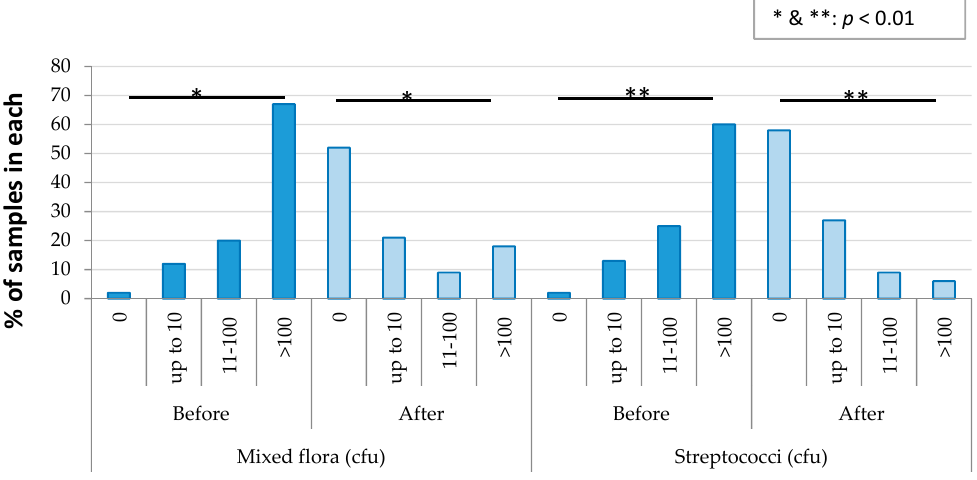
Figure 6. Reduction in the number of organisms due to disinfection in the prosthetic